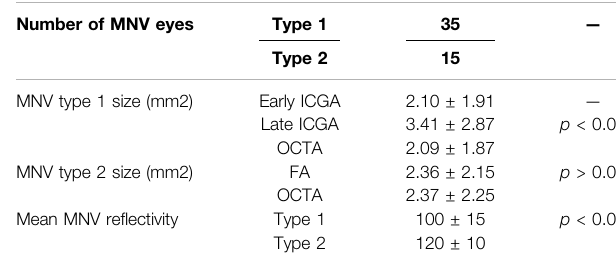
TABLE 1 | Quantitative analyses. The following abbreviations are used: macular neovascularization (MNV), fl uorescein angiography (FA), indocyanine green angiography